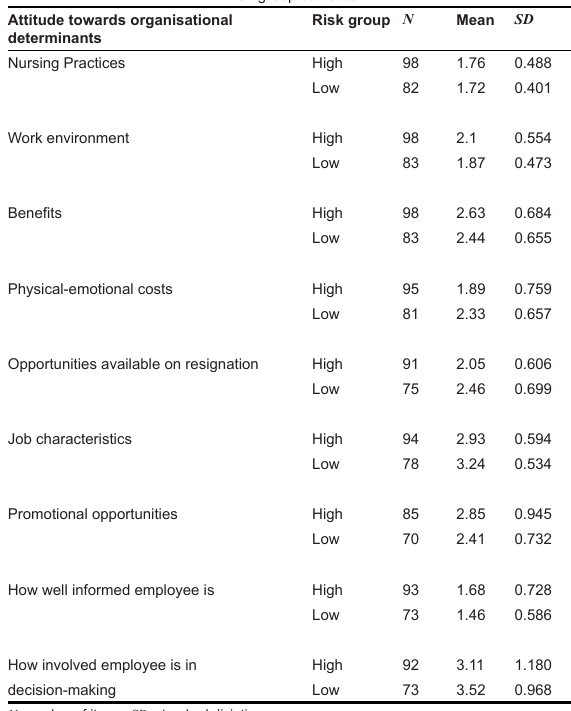
TABLE 7 Risk-group